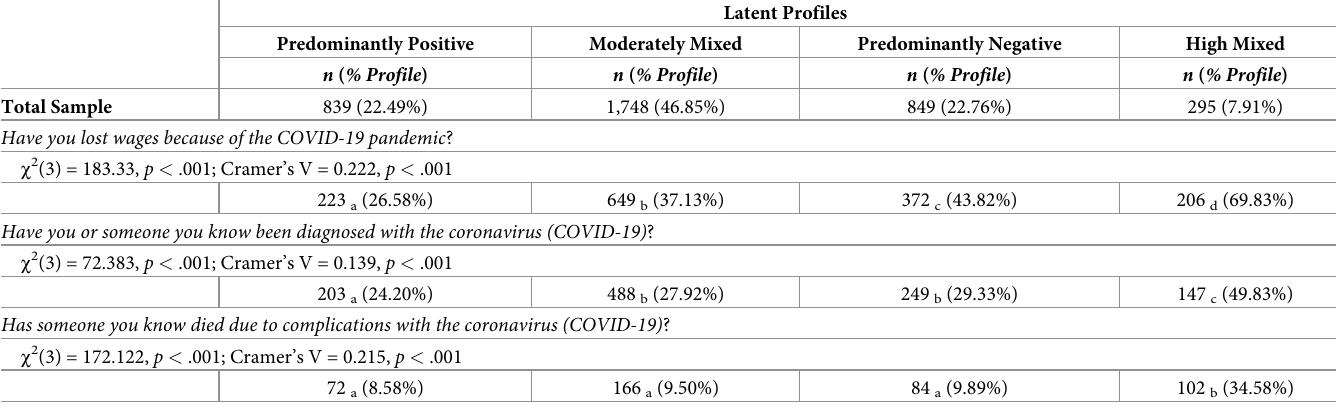
Table 6. Proportion of individuals endorsing specific COVID-19 experiences across the four latent